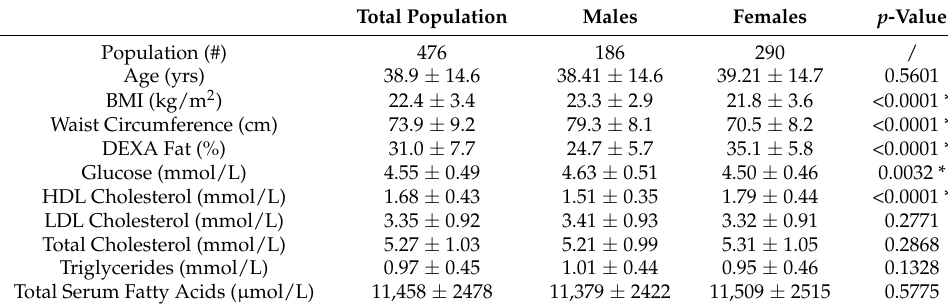
Table 1. General characteristics of study population.